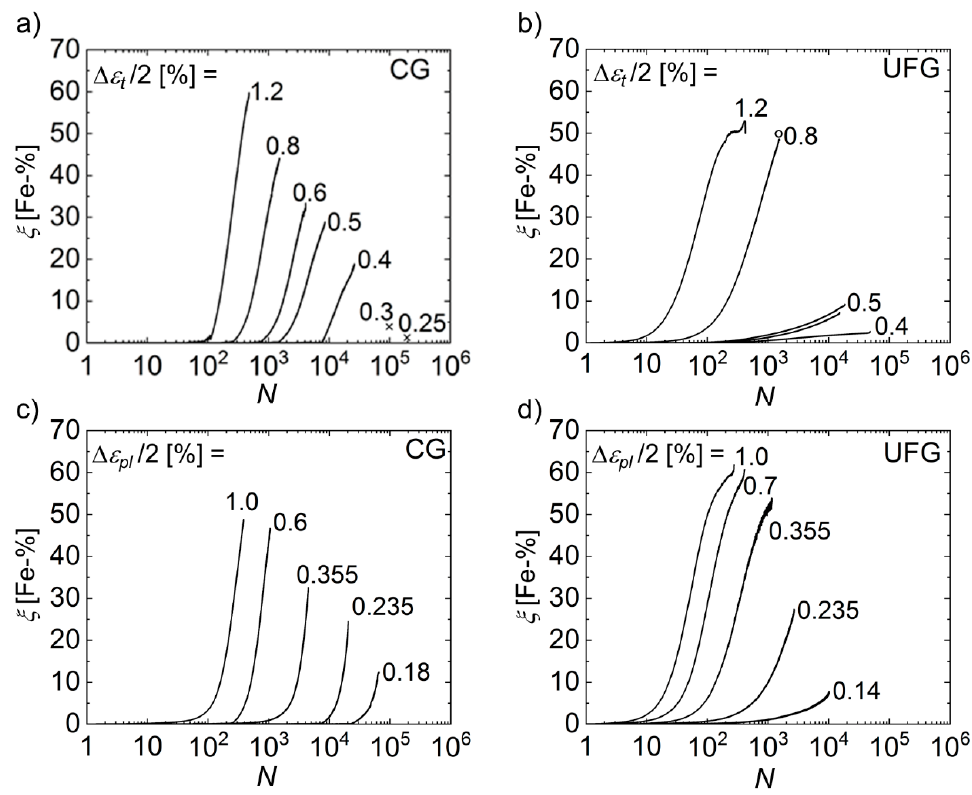
Figure 4 . Evolution of ferromagnetic phase fraction in CG ( a , c ) and UFG material ( b , d ) conditions during cyclic loading under ( a , b ) total strain control and ( c , d ) plastic strain control with different amplitudes.